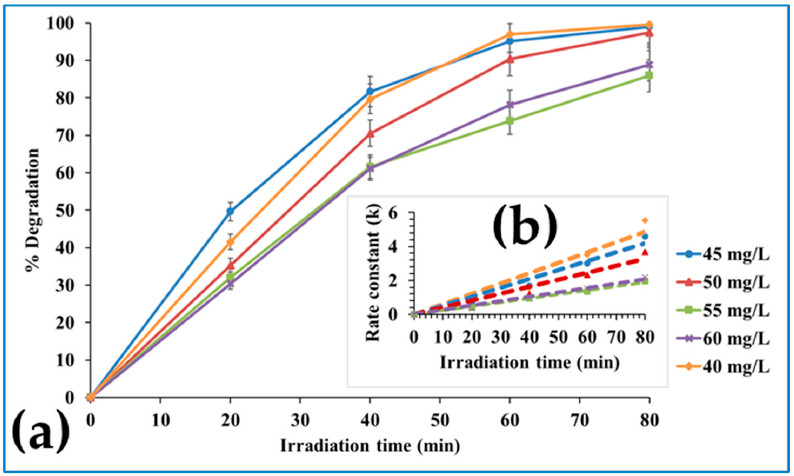
Figure 14. ( a ) Effect of initial IBU concentration on the photocatalytic degradation performance of 1 g/L Mo/HRTiO 2 under natural (unmodified) pH ~ 4 and 365 nm irradiation, and ( b ) their corresponding photocatalytic degradation rate constant (k).